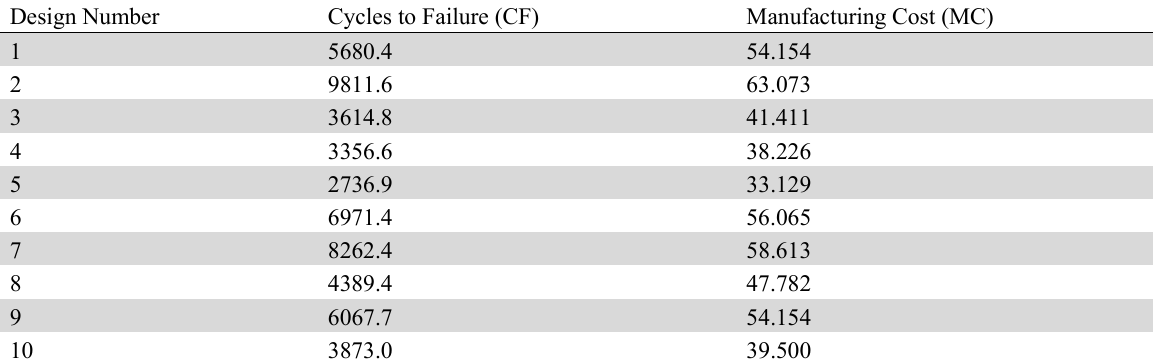
The weighted decision matrix Design